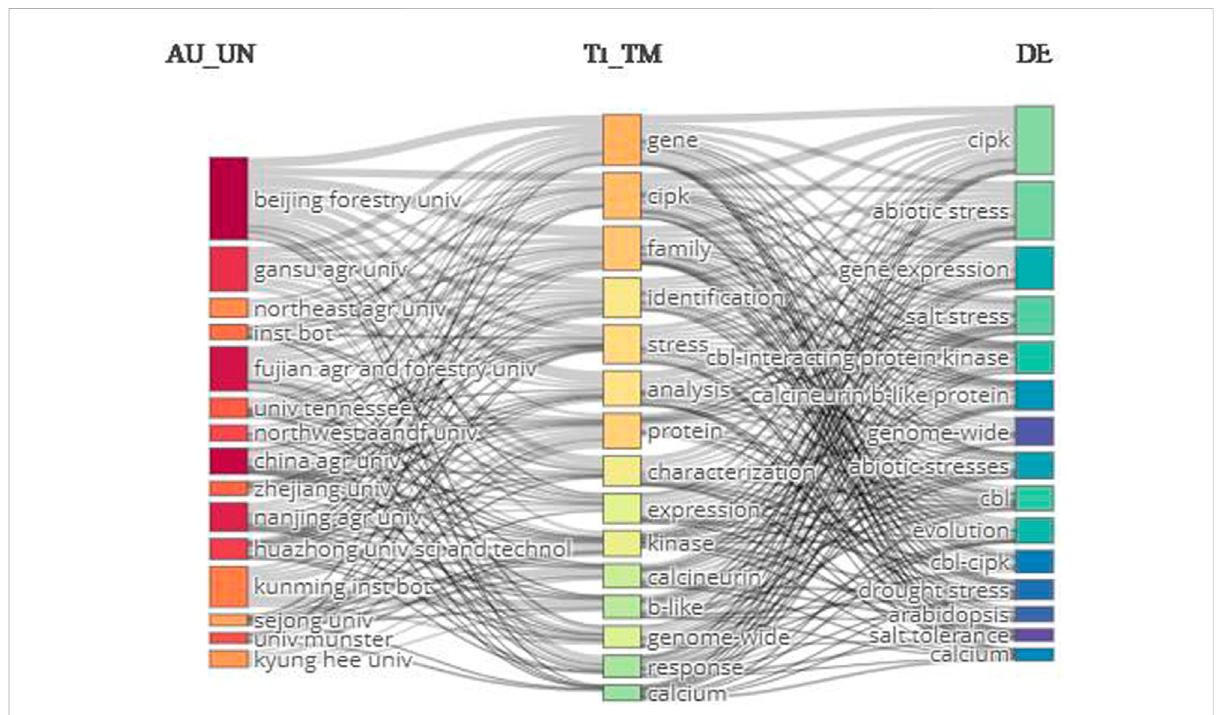
FIGURE 9 Three- fi eld network map. The right-hand, middle, and left-hand sides show the keywords, terms extracted from titles, and author af fi liations, respectively.